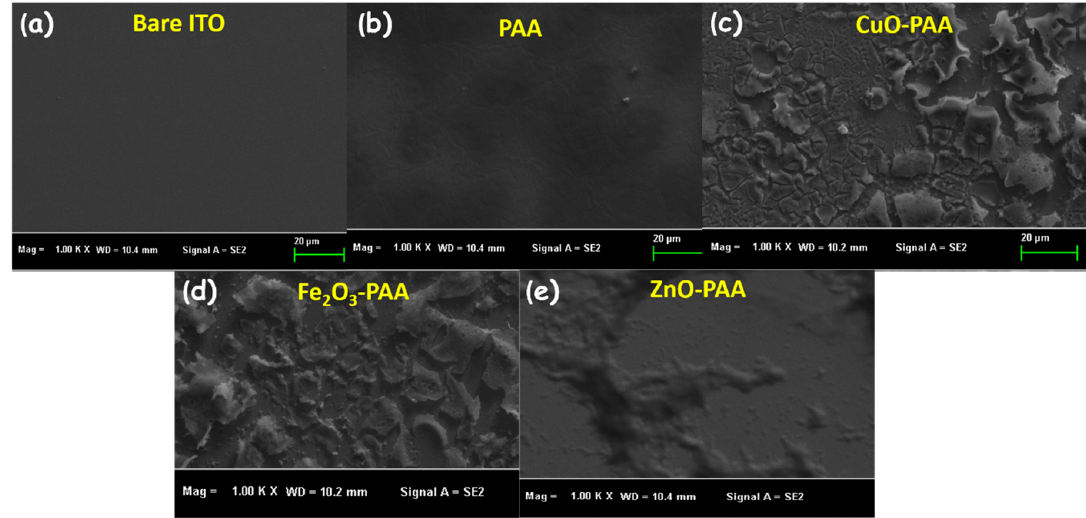
Figure 2. Scanning electron microscopy (SEM) images of ( a ) bare ITO, ( b ) PAA, ( c ) CuO–PAA, ( d ) Fe 2 O 3 –PAA and ( e ) ZnO–PAA coated on ITO.